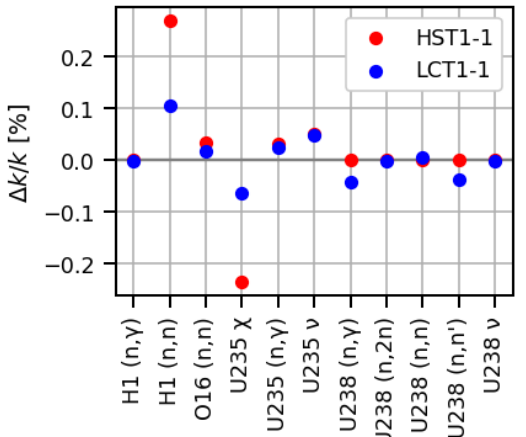
Figure 4. The average amount of criticality adjustment due to each nuclide reaction by 84,120 cross-section sets ( Δ𝑘 𝑘⁄ > 1.0 × 10 −3 %